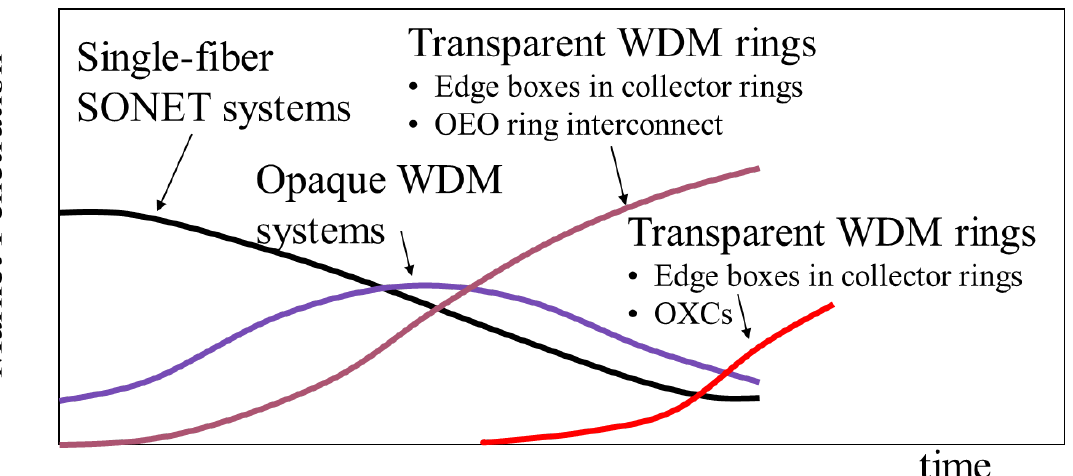
Figure 23. Evolution of transport network architectures from single channel SONET systems to WDM based networks supporting various transport protocols.